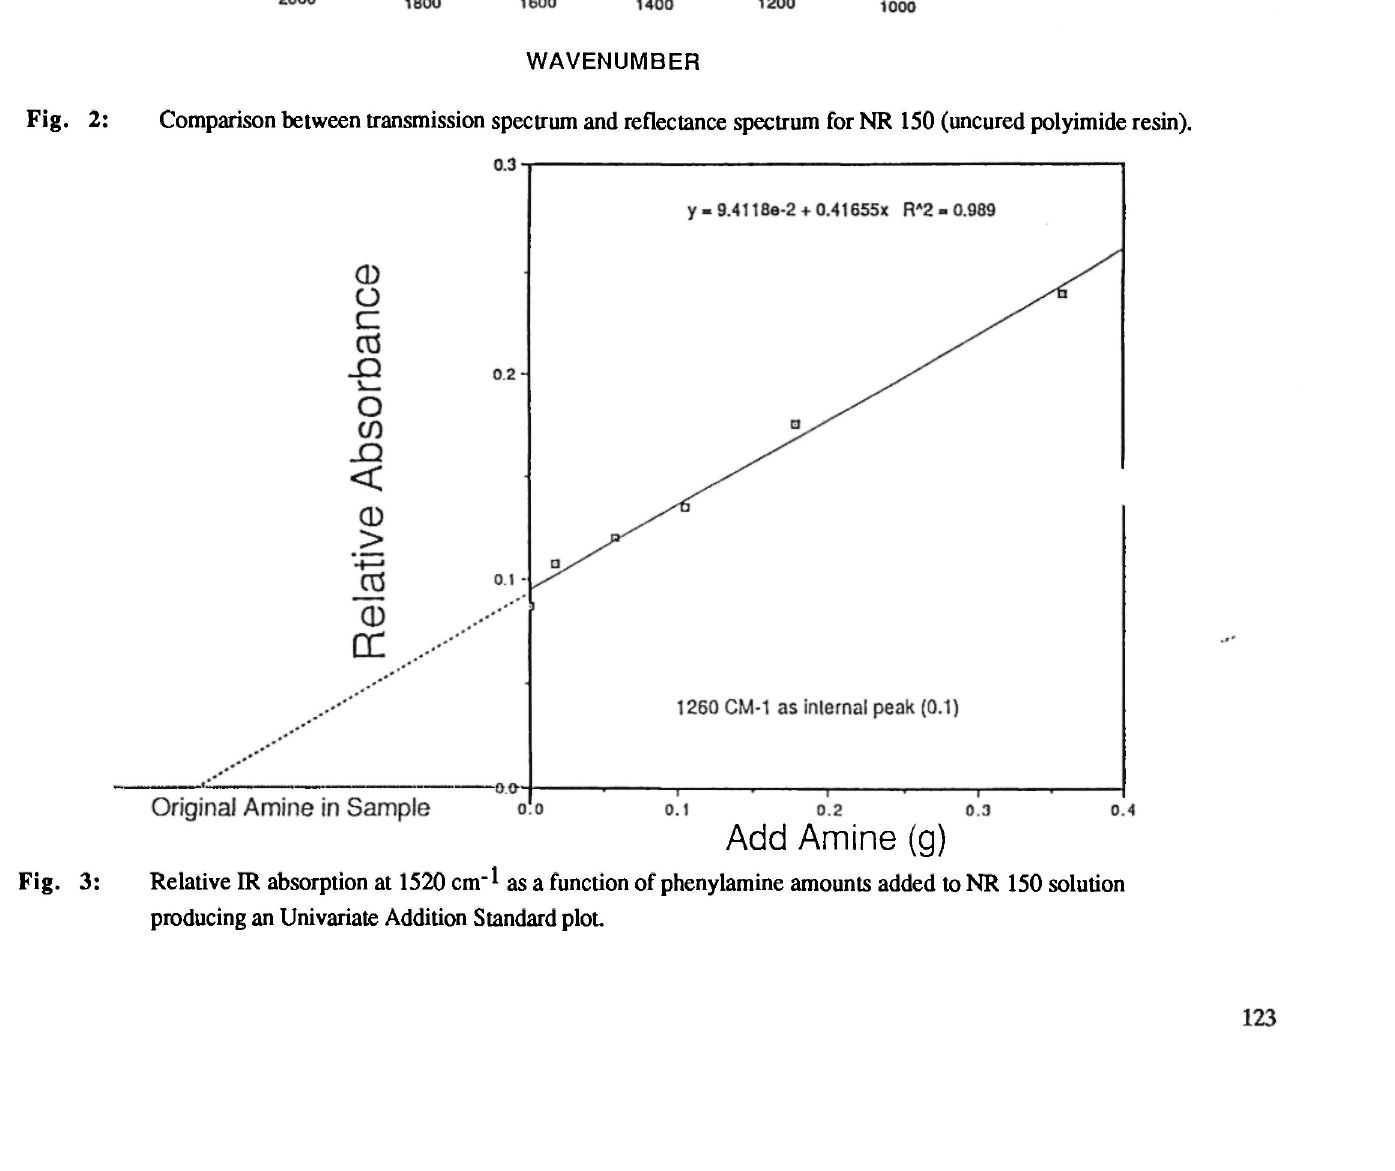
Fig. 2: Comparison between transmission spectrum and reflectance spectrum for NR 150 (uncured polyimide resin).